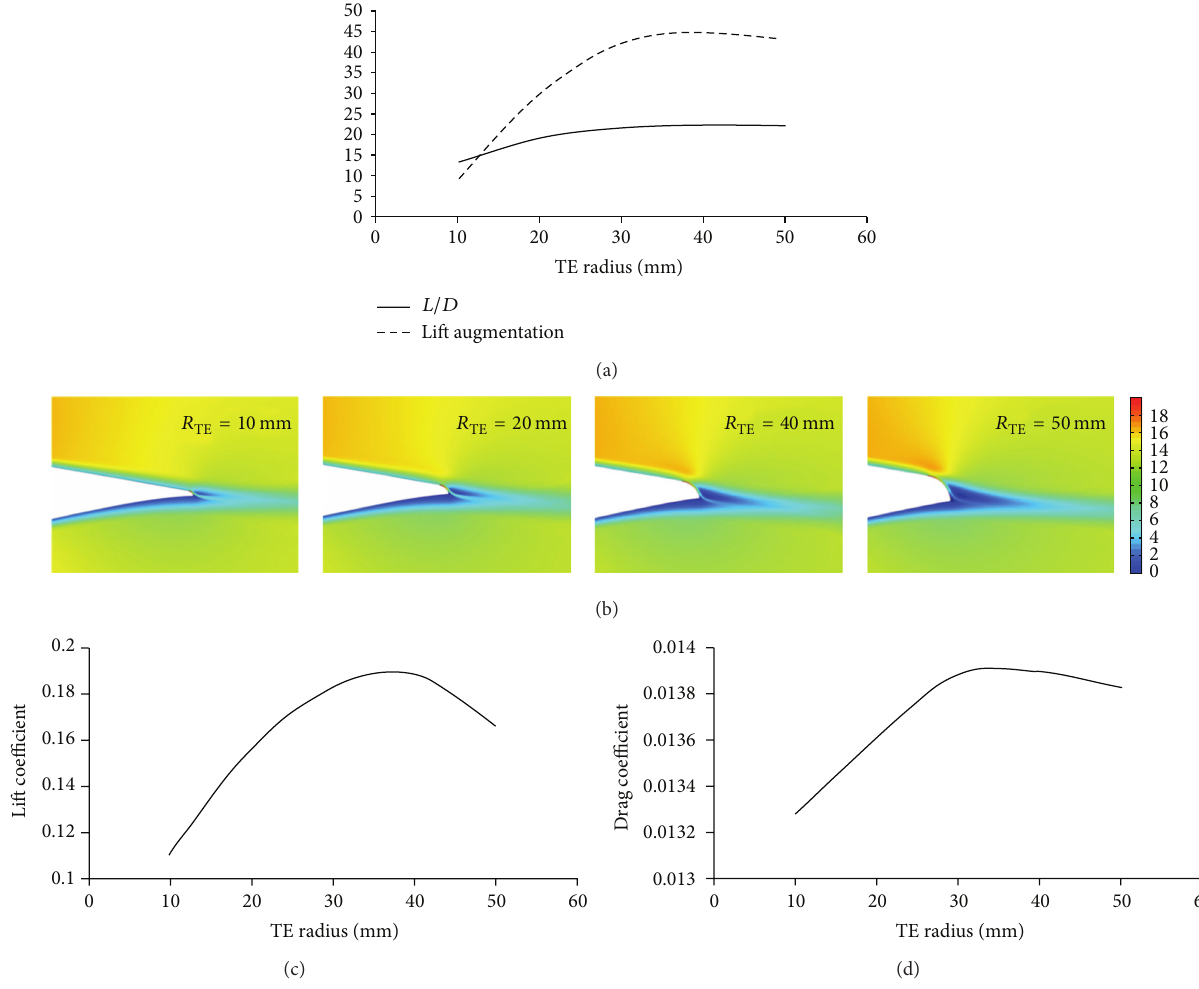
Figure 10: (a) The effect of TE radius on L / D with Coand˘a-jet (Re = 1 × 10 6 , 𝐶 𝜇 = 0.005 , t = 1mm); (b) velocity flow field for different TE radius; (c) lift coefficient; (d) drag